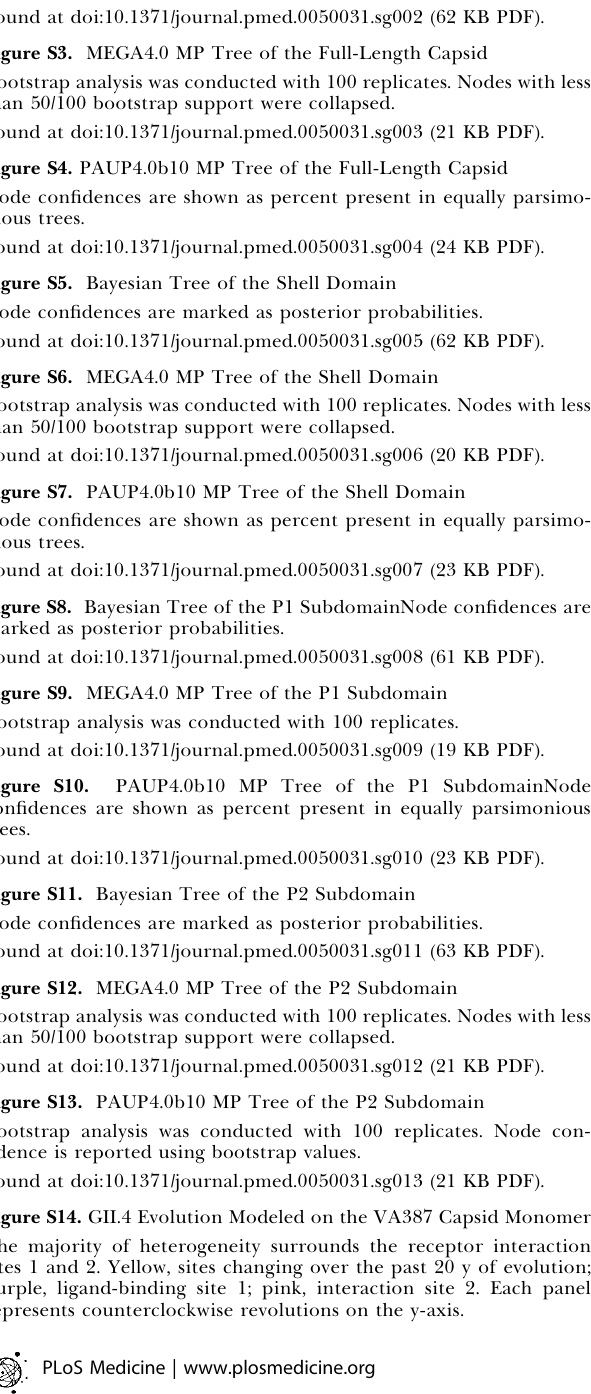
Found at doi:10.1371/journal.pmed.0050031.sg013 (21 KB PDF). Figure S14. GII.4 Evolution Modeled on the VA387 Capsid Monomer The majority of heterogeneity surrounds the receptor interaction sites 1 and 2. Yellow, sites changing over the past 20 y of evolution; purple, ligand-binding site 1; pink, interaction site 2. Each panel represents counterclockwise revolutions on the y-axis.